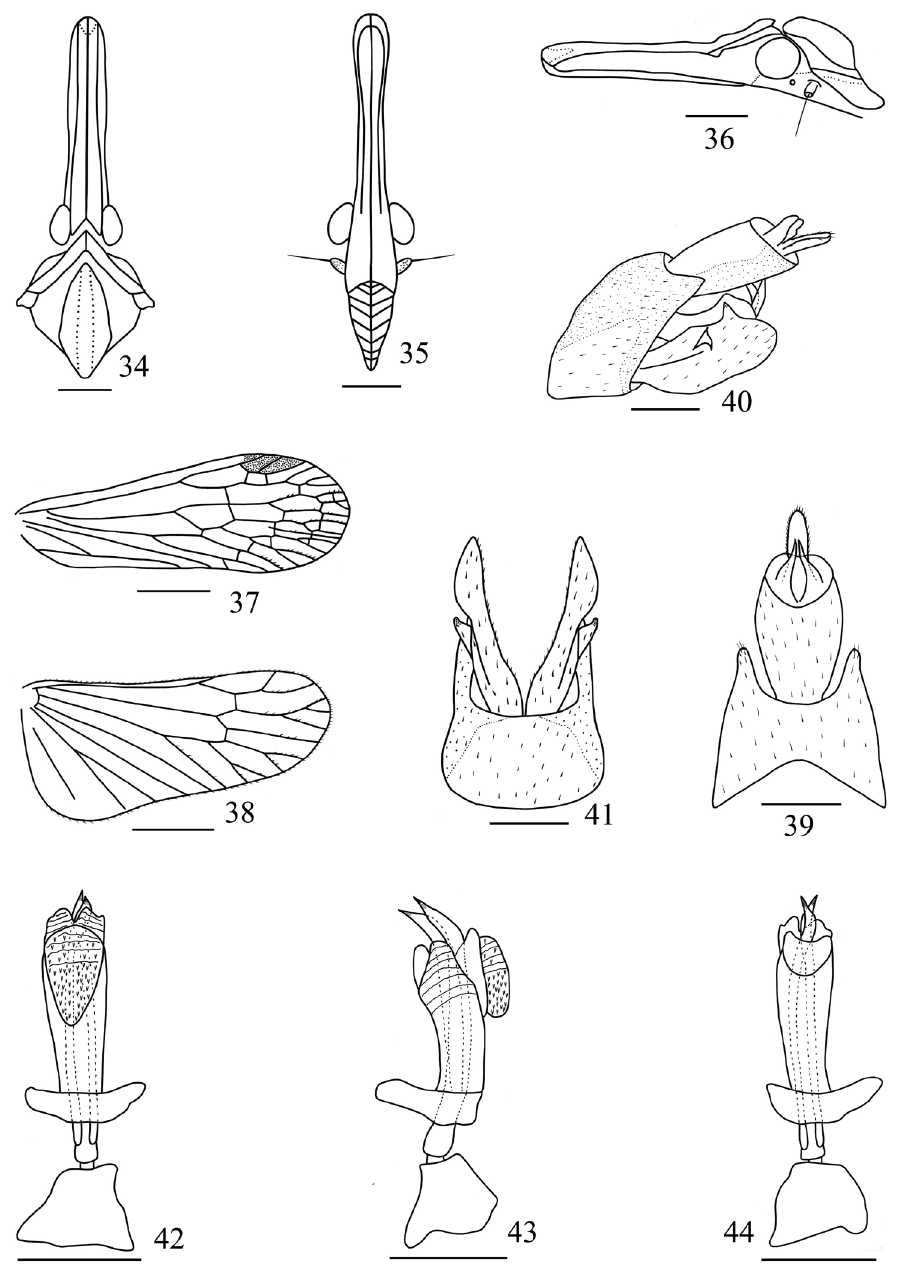
Figures 34–44. Saigona tenuisa Zheng, Yang & Chen, sp. n. 34 Head and thorax, dorsal view 35 Frons and clypeus, ventral view 36 Head and pronotum, lateral view 37 Forewing 38 Hindwing 39 Pygofer and anal tube, dorsal view 40 Genitalia, lateral view 41 Pygofer and parameres, ventral view 42 Aedeagus, ventral view 43 Aedeagus, lateral view 44 Aedeagus, dorsal view. Scale bars: 34–38 = 1 mm, 39–44 = 0.5